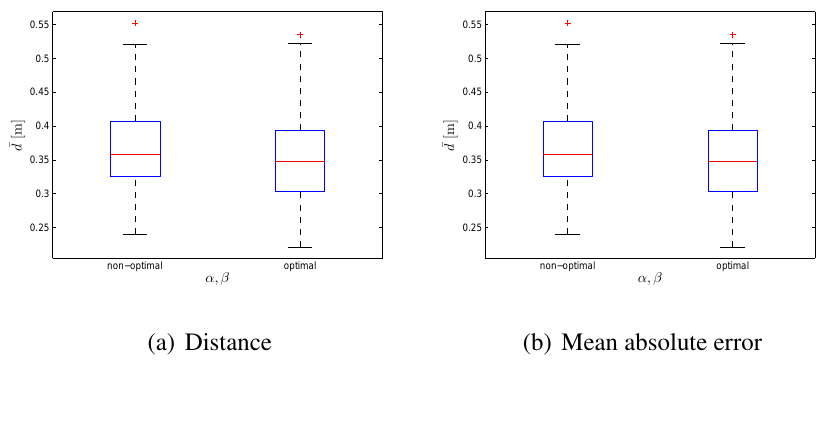
Figure 6. Box-plot comparison for 100 robots and 4 random-valued, randomly distributed targets; (cid:11) = (cid:12) = 1 and (cid:11) = 2 : 65 ; (cid:12) = 2 : 55 : (a) distance; (b) MAE. Each box-plot comprises observations ranging from the first to the third quartile. The median is indicated by a horizontal bar, dividing the box into the upper and lower part. The whiskers extend to the farthest data points that are within 1.5 times the interquartile range. Outliers are shown with a plus symbol. The values were obtained from 50